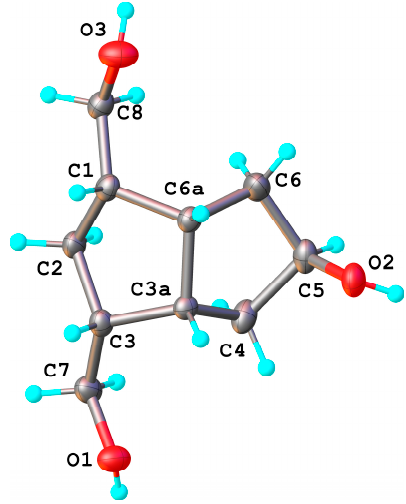
Figure 2. X-ray molecular structure of the symmetrical triol compound 8 with thermal ellipsoids at 50% probability level. Proposed atom numbering is shown in the scheme attached and will be kept the same for all compounds.